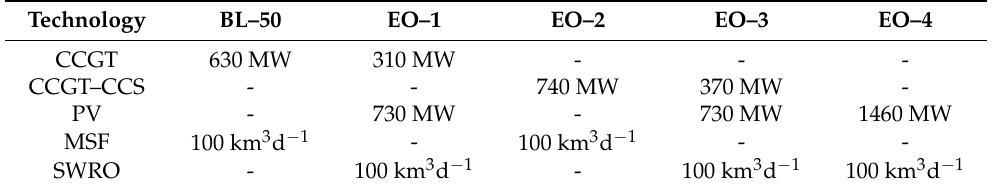
Table 4. Cogeneration capacities for baseline and expansion options configurations.